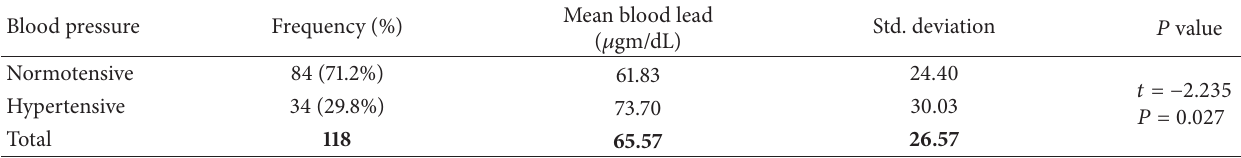
Table 5: Blood pressure status and mean blood lead level of the